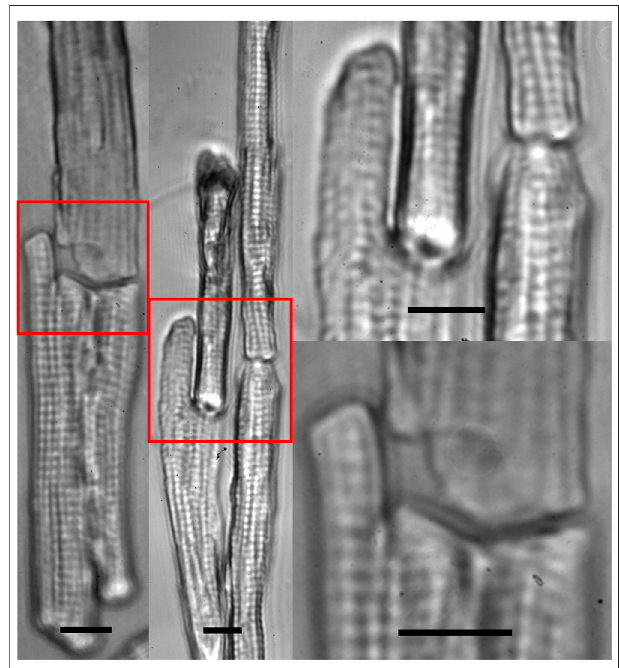
FIGURE 5 | Zoom-in images of multiple beam-patterned adult cardiomyocytes with end-to-end intercellular connections in culture in the on- stage incubator imaged with the patterning microscope 30 min after completion of the pattern (scale bars (cid:2) 10